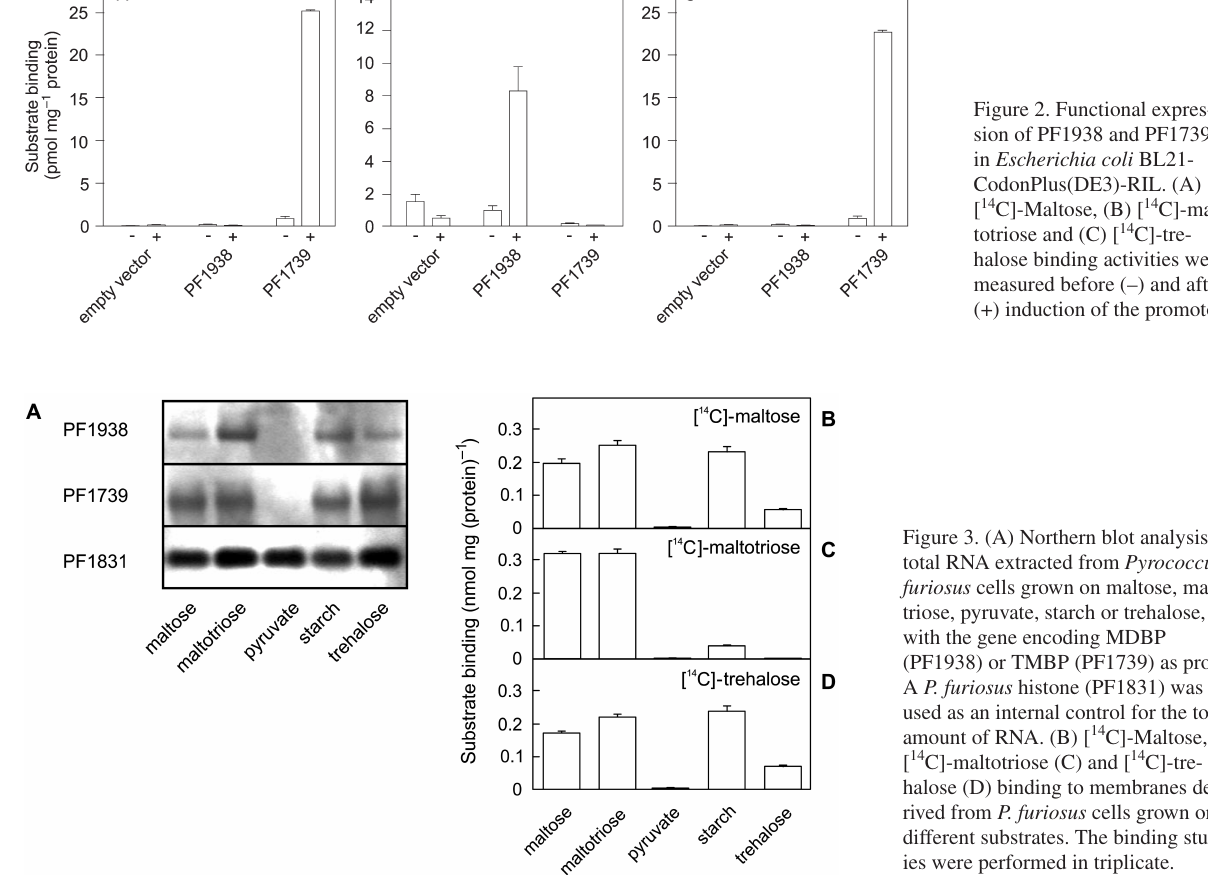
Figure 2. Functional expres- sion of PF1938 and PF1739 in Escherichia coli BL21- CodonPlus(DE3)-RIL. (A) [ 14 C]-Maltose, (B) [ 14 C]-mal- totriose and (C) [ 14 C]-tre- halose binding activities were measured before (–) and after (+) induction of the promotor.